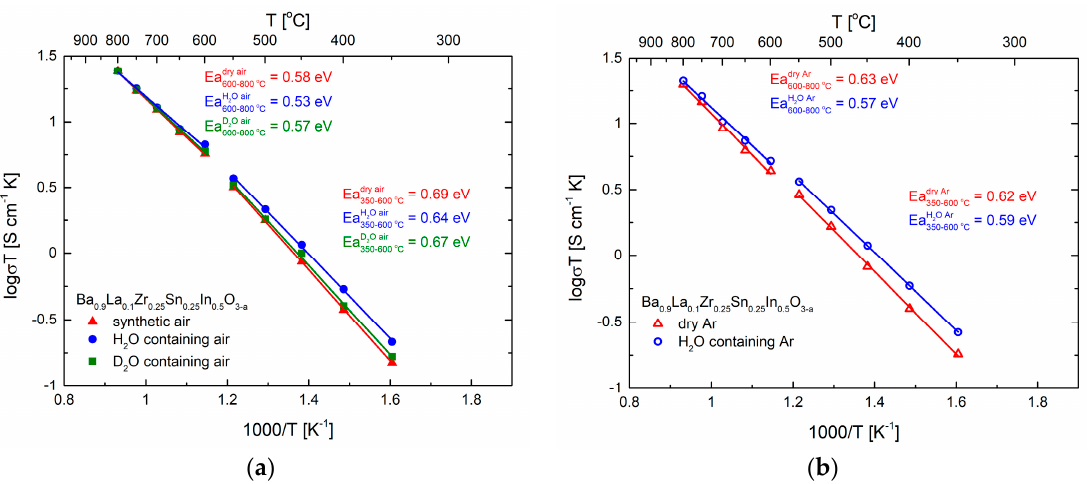
Figure 8. ( a ) Temperature dependence of the electrical conductivity of Ba 0.9 La 0.1 Zr 0.25 Sn 0.25 In 0.5 O 3 − a in dry, H 2 O-, and D 2 O-containing air, with calculated values of the activation energy. Data shown in Arrhenius-type coordinates; ( b ) Temperature dependence of the electrical conductivity of Ba 0.9 La 0.1 Zr 0.25 Sn 0.25 In 0.5 O 3 − a in dry and H 2 O- containing Ar, with calculated values of the activation energy. Data shown in Arrhenius-type coordinates.